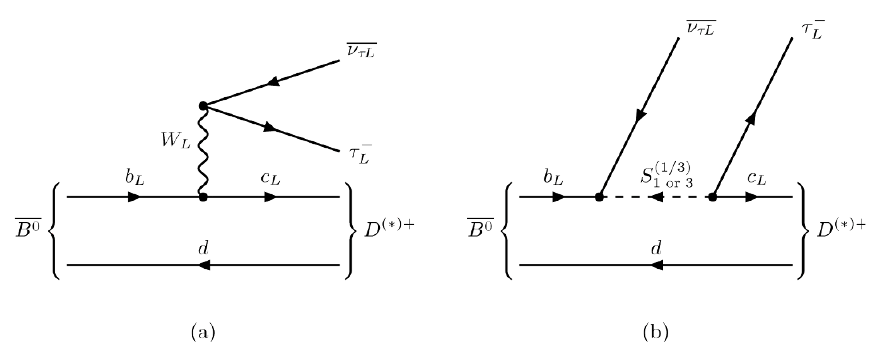
Figure 3 . (a) SM and (b) possible leptoquark contributions to B 0 ! D ( (cid:3) )+ (cid:28) (cid:0) (cid:23) (cid:28)L